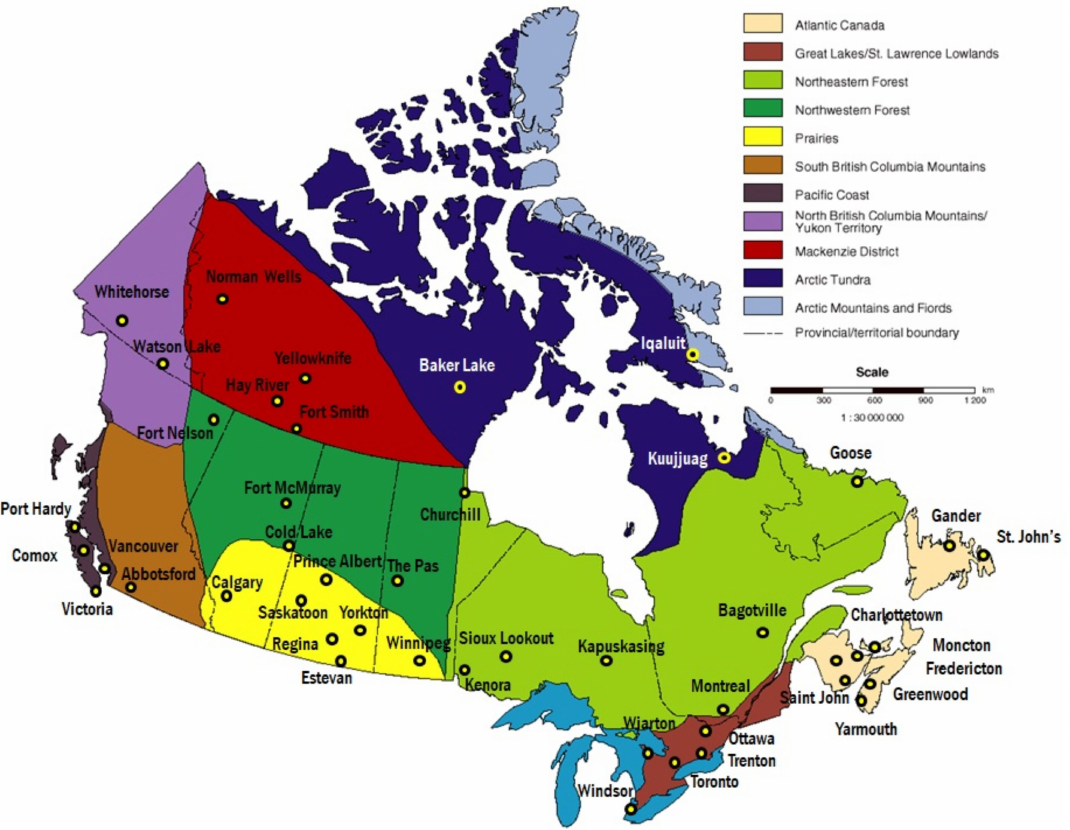
Figure 2. Positions of climate stations on the map of Canadian Climate Regions. (Adapted from Climate Trends and Variations Bulletin for Canada , Ottawa. Environment Canada, Atmospheric Environ- ment Service, Climate Research Branch, 1998). Table 1. List of climate stations with latitude, longitude, data range, and percentage of